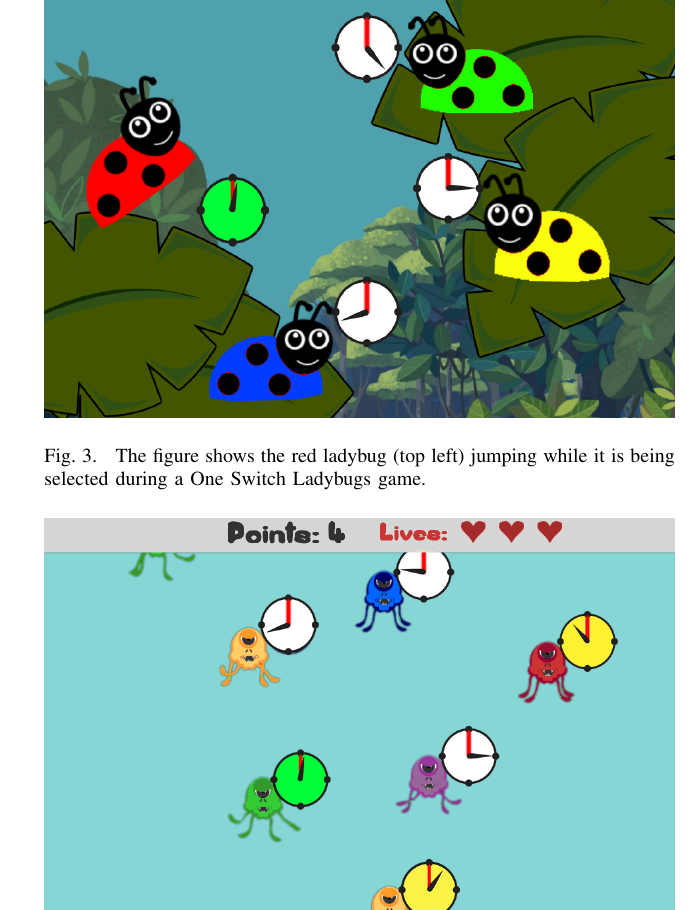
Fig. 4. The figure shows six aliens falling down the screen while the green one (at the left) is being selected during a game of One Switch